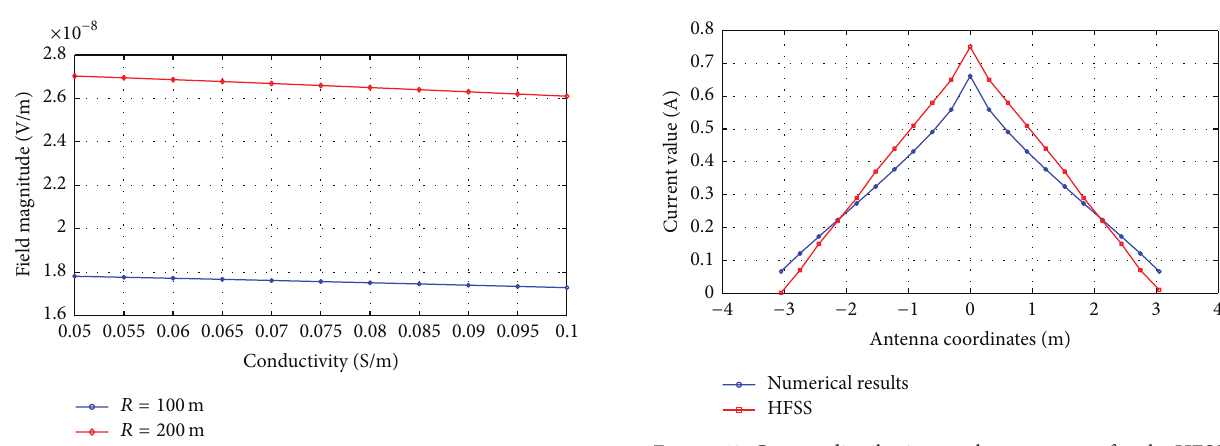
Figure 10: Curves of the radial component of the electric field magnitude with the conductivity.